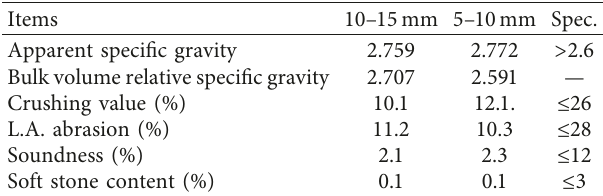
Table 3: Physical properties of coarse limestone.